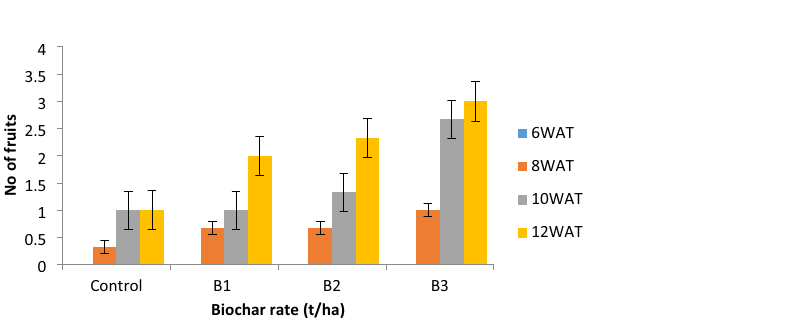
Figure 6. Effect of different rates of biochar on the number of flowers of tomato at different weeks of planting. B1 = 2.5 t/ha, B2 = 5.0 t/ha, B3 = 7.5 t/h and WAT = Weeks After Transplanting.